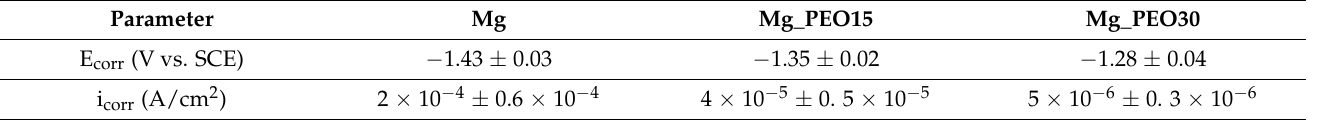
Figure 7. Potentiodynamic curves of the investigated samples exposed to Hank’s solution at 37 °C. The corrosion potential, E corr , and the corrosion current density, i corr , values are reported in Table 3. Table 3. Corrosion potential and current density of corrosion values of the investigated samples in Hank’s solution.